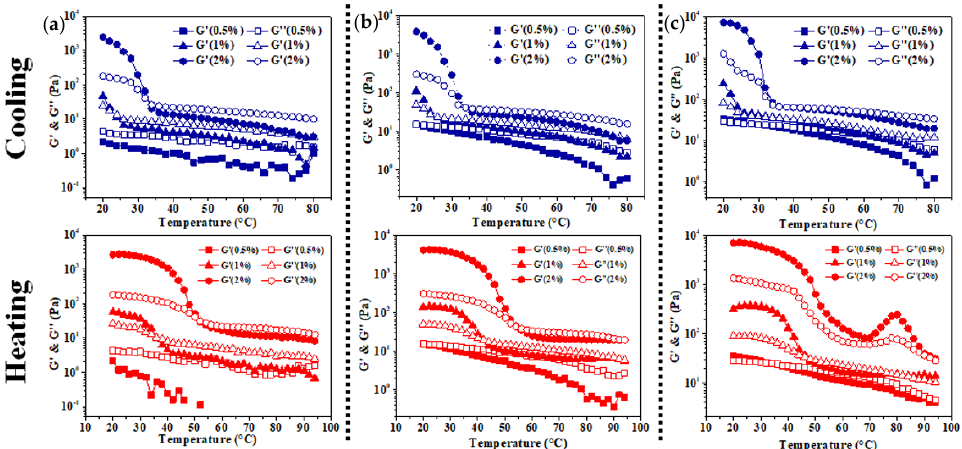
Figure 5. Gelation process and gel-melting process of Pickering emulsion gels stabilized by XG/Ly NPs (( a ) 0.5%, ( b ) 1%, ( c ) 2%) with kC (0.5%, 1%, 2%).